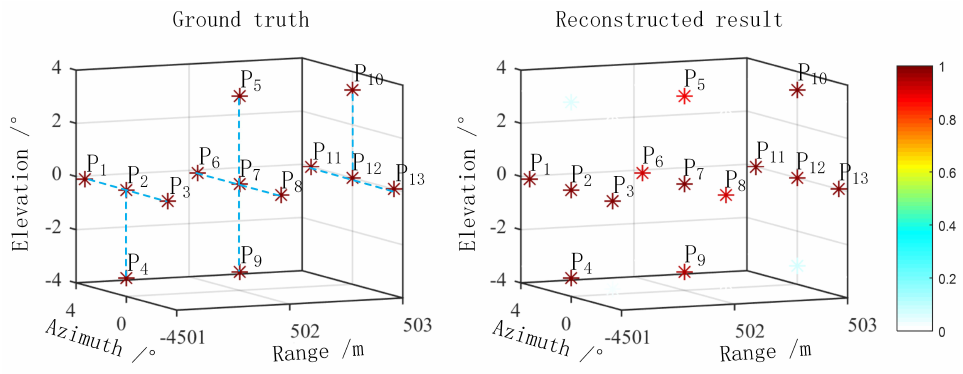
Figure 11. Range-azimuth-elevation three-dimensional imaging